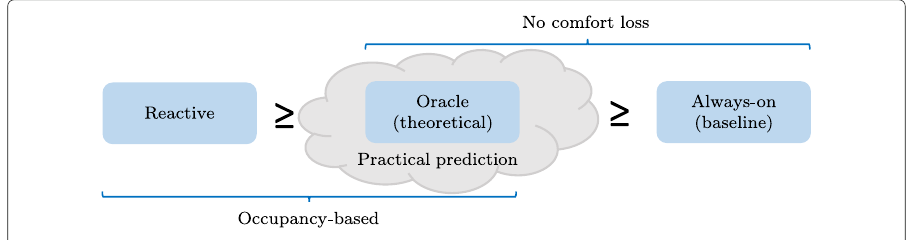
Fig. 3 The order of savings potential and key characteristics of our heating strategies. The practical prediction strategy represents a system approximating the oracle strategy, however potentially suffering from prediction inaccuracies, which affect either the comfort or the savings. If the home is predicted to be unoccupied while it is occupied, it will not be heated, although the inhabitants are present. If the home is predicted to be occupied although it is unoccupied, it will be heated